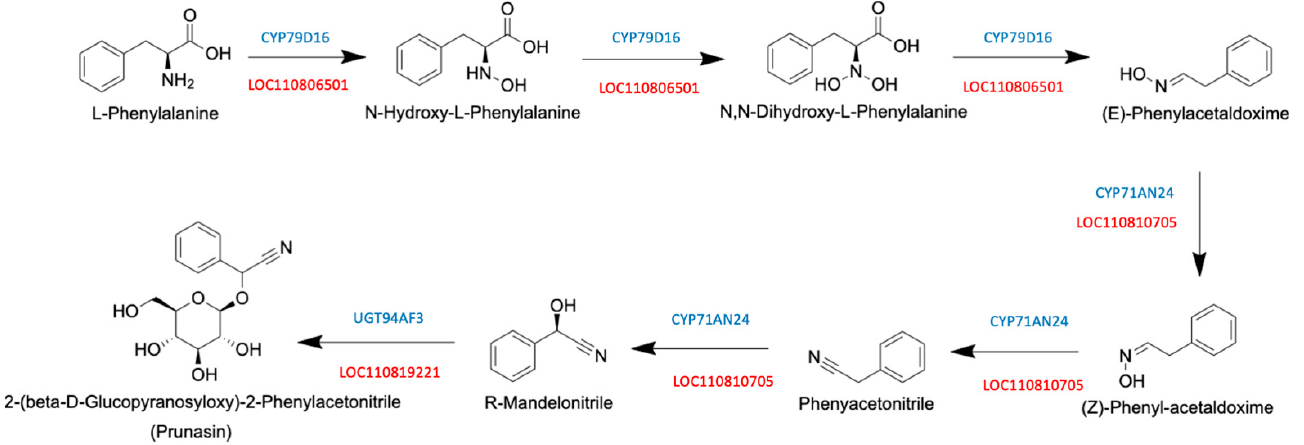
Figure 5. Proposed prunasin pathway in papaya. The fonts in blue represent known prunasin biosynthetic genes encoding enzymes in P. dulcis [105], and those in red represent the corresponding papaya enzymes identified using BLASTp.